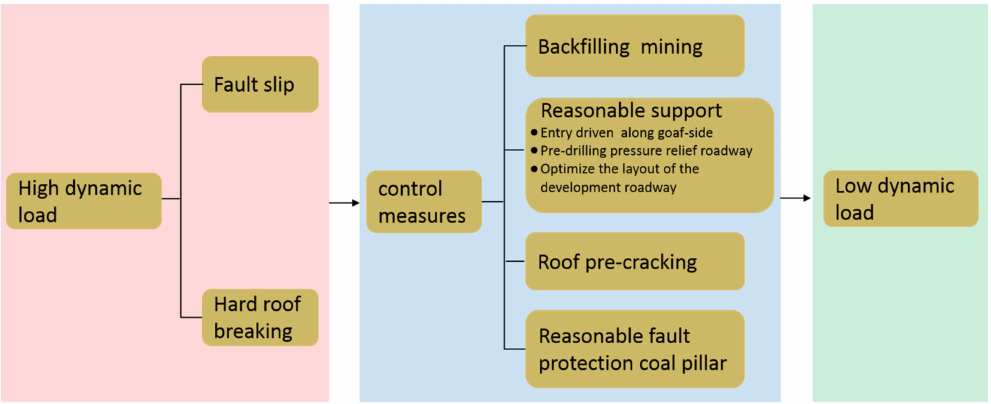
Figure 14. High dynamic load source and control